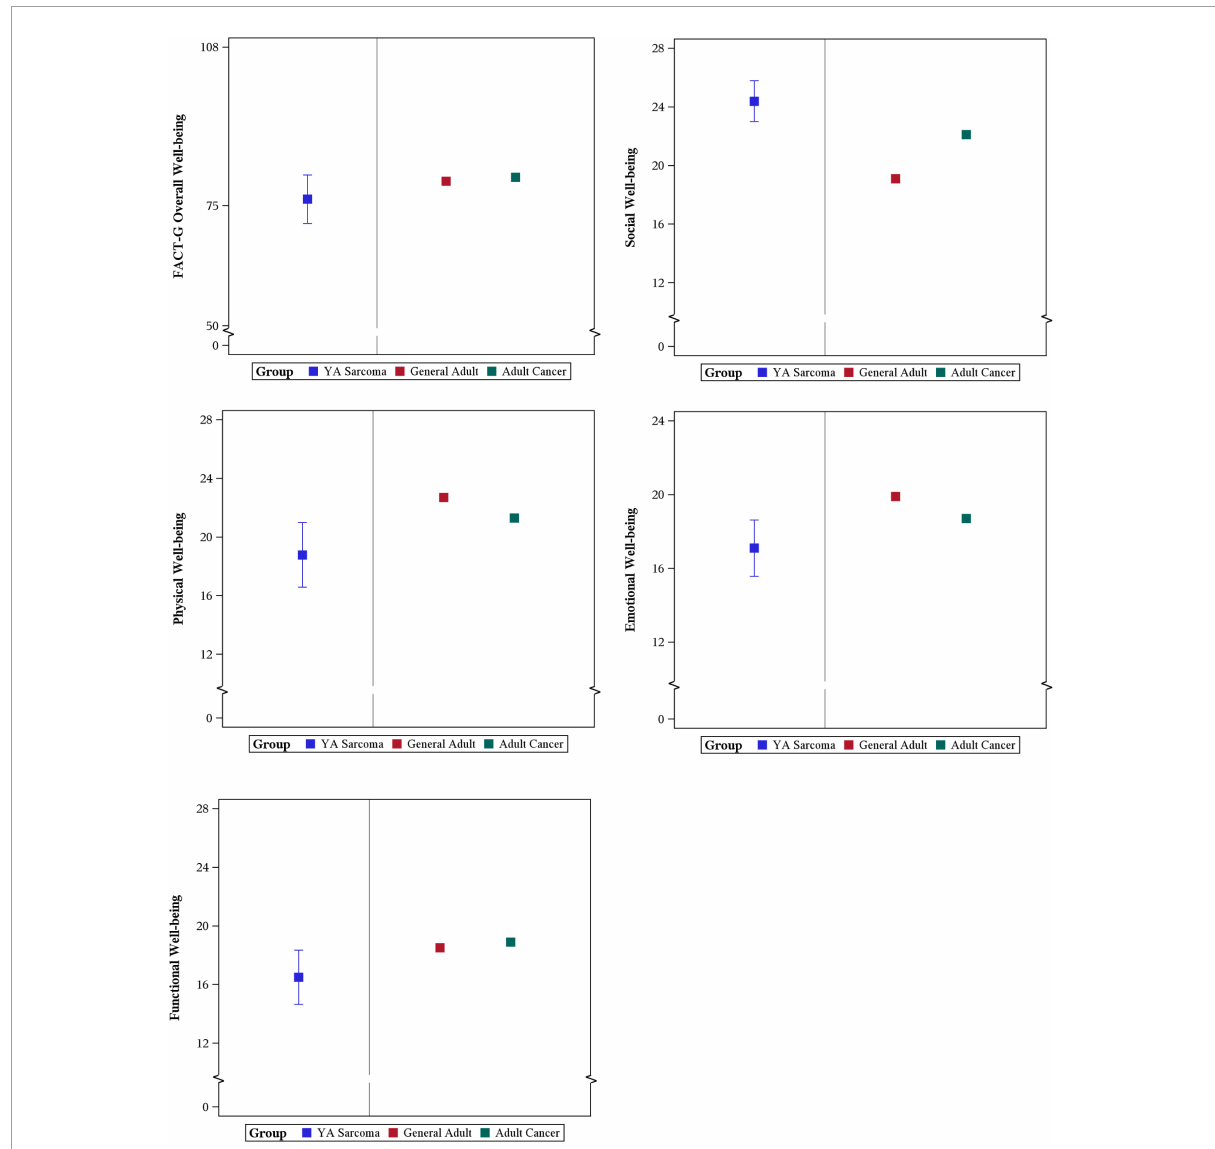
FIGURE5 Comparison of YA patient reported FACT-G scores with General Adult and Adult with Cancer Population